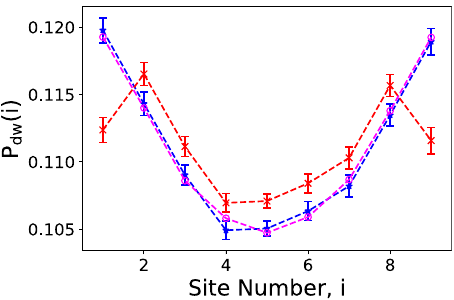
Fig. 3 Domain-wall probability distributions for 10-qubit fru- strated chain. Crosses are raw experimental data. Asterisks are the same with a correction applied for background susceptibility. Circles are numerically calculated data from sampling Boltzmann distribu- tions with fi eld noise of the form Eq. 4 with σ ζ joining points are a guide to the eye.